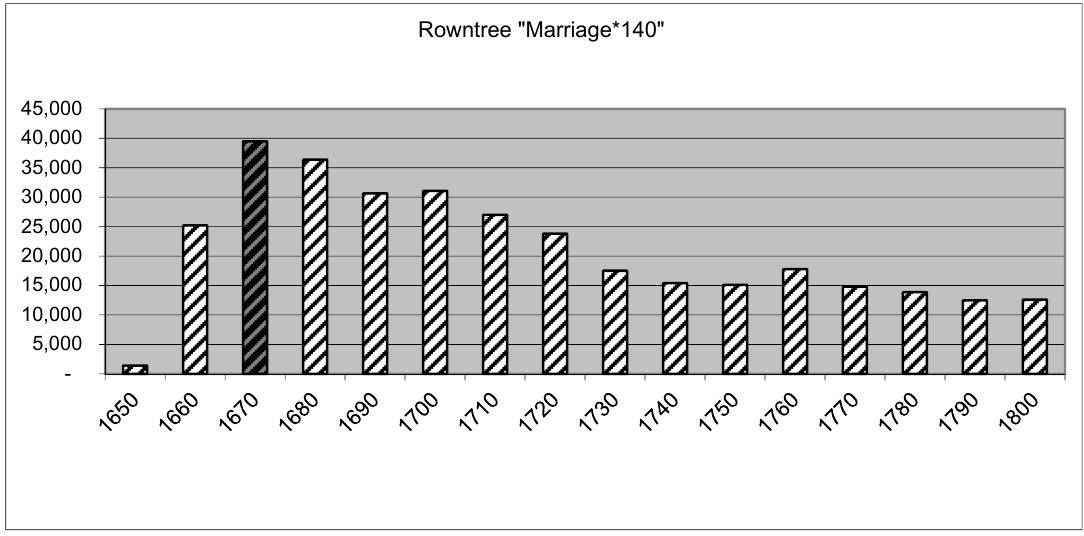
Figure 1. Estimates of English Quaker population using JS Rowntree’s “Marriage Ratio” (140) 13.